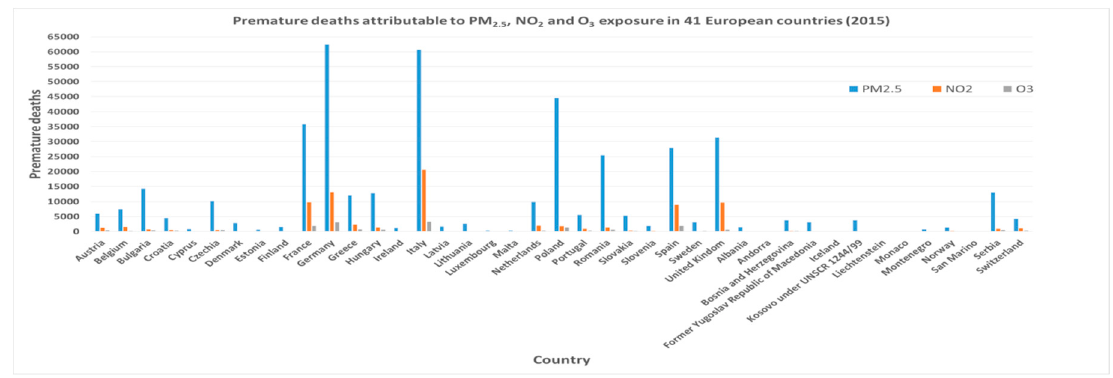
Figure 2. Premature deaths attributable to PM 2.5 , NO 2 and O 3 exposure in 41 European countries and the EU-28, 2015 (Modified from Air quality in Europe—2018 report , EEA, [24]).